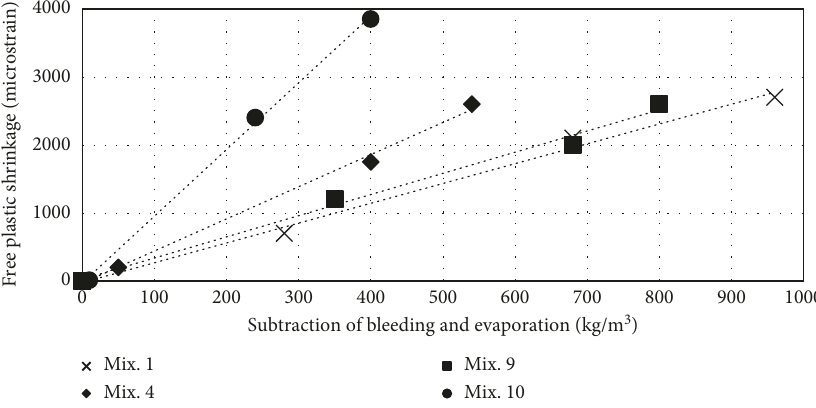
Figure 8: Free plastic shrinkage versus the difference between bleeding and